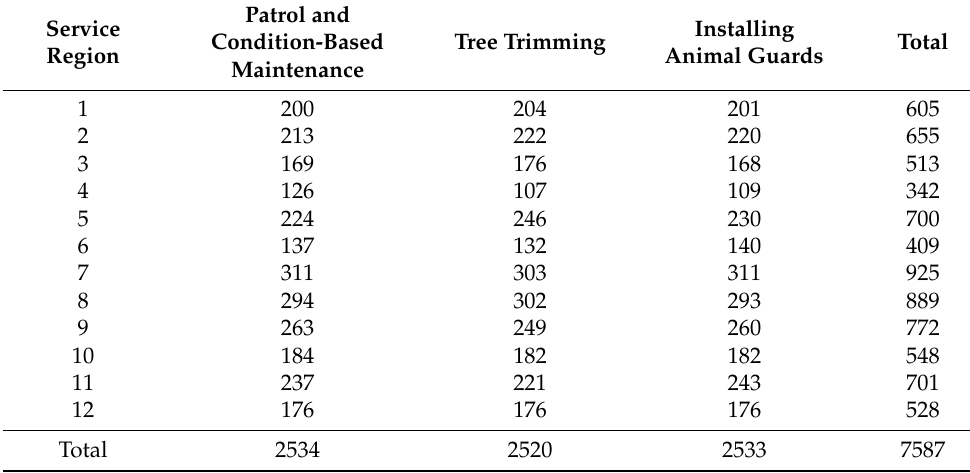
Table 5. Number of preventive maintenance tasks categorized by maintenance type. Patrol and Service Condition-Based Tree Trimming Region